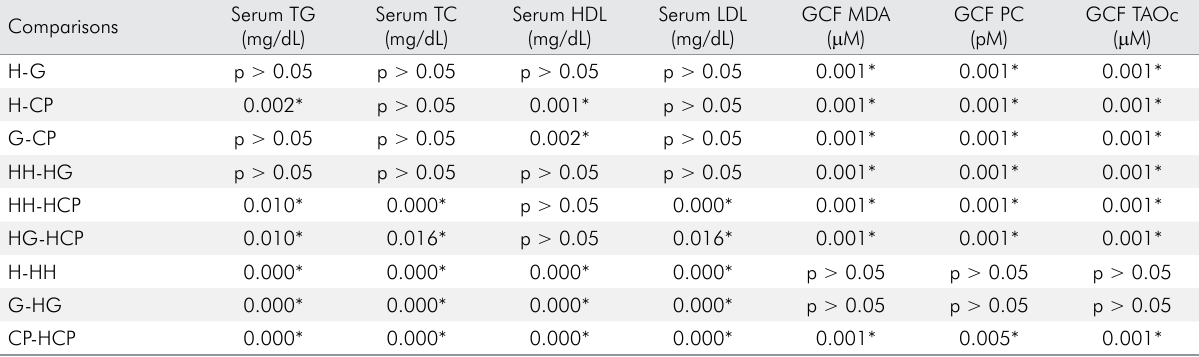
Table 3. Comparisons of blood serum and GCF biomarkers between the study groups (p-value).